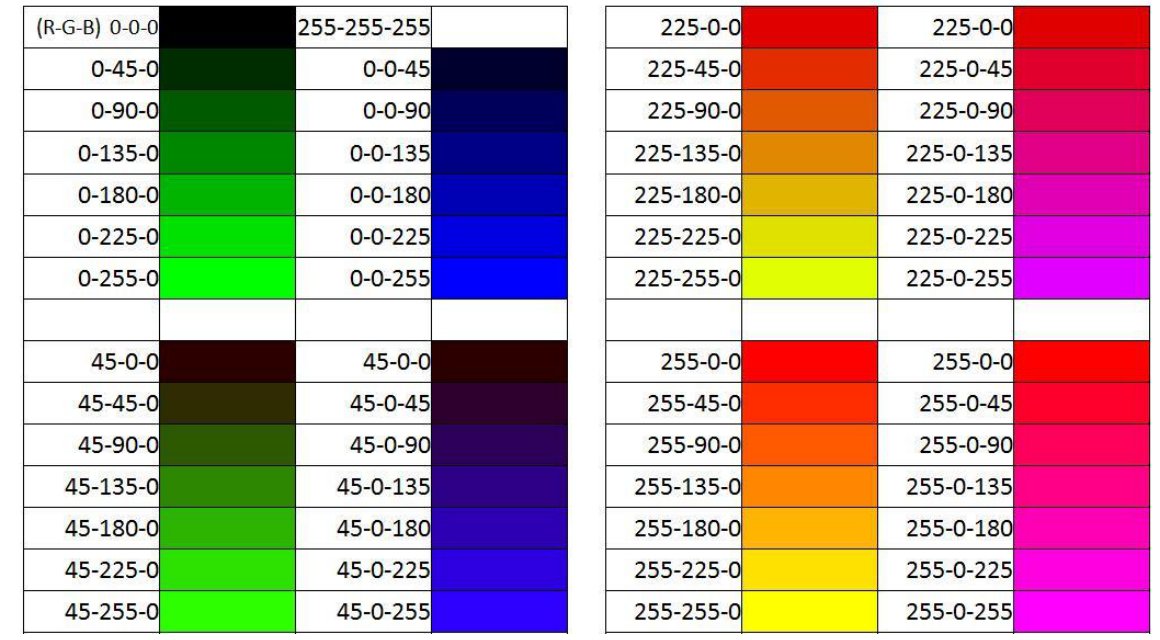
Figure 5. A part of color palette to constitute training/test